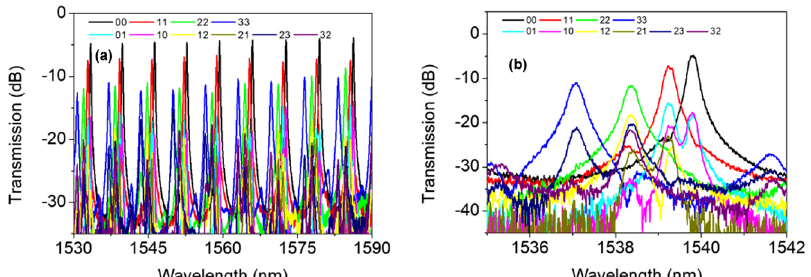
Figure 6: Measured transmission spectra of the MMRR for TE 0 – TE 3 mode input (a) from 1530 to 1590 nm and (b) within one FSR.